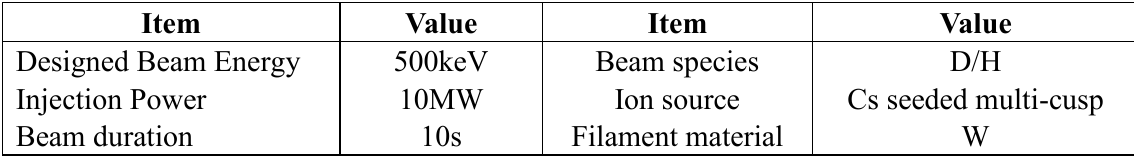
Table 1. Design specification of JT-60U N-NBI system